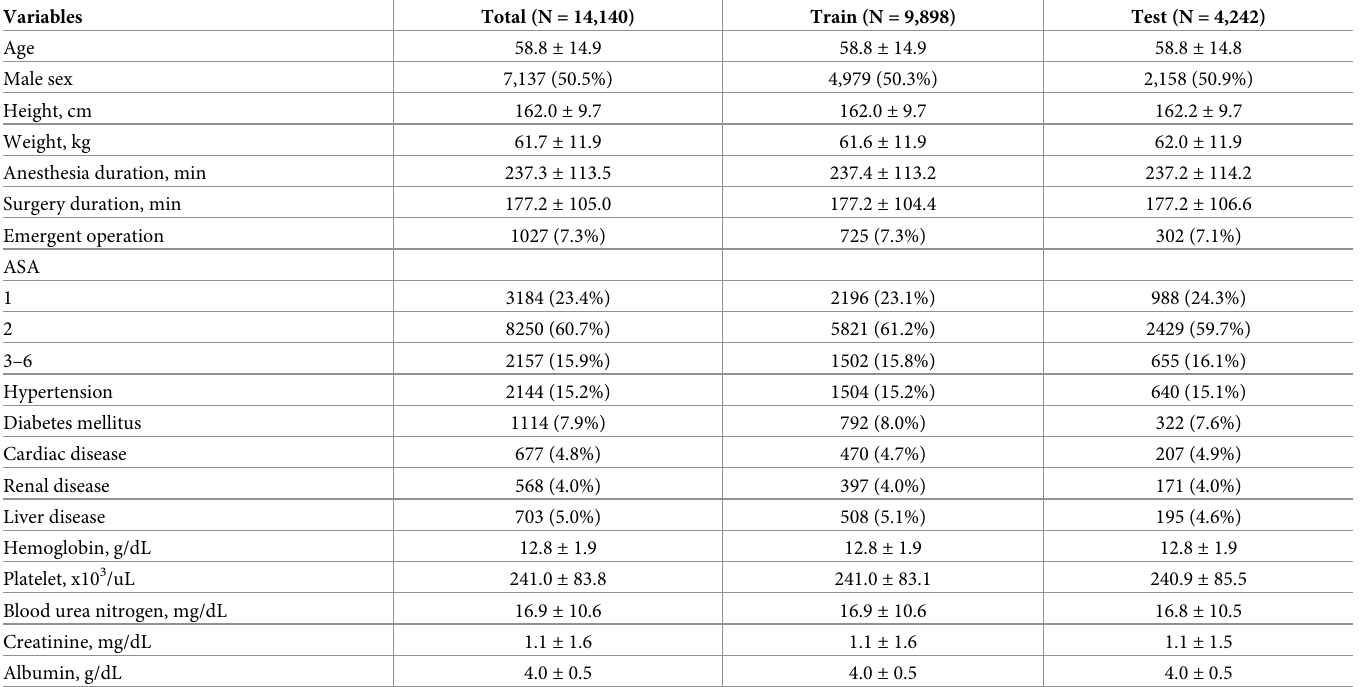
Table 1. Dataset characteristics. Overall missing values are below 1%. ASA, American Society of Anesthesiologists classification.